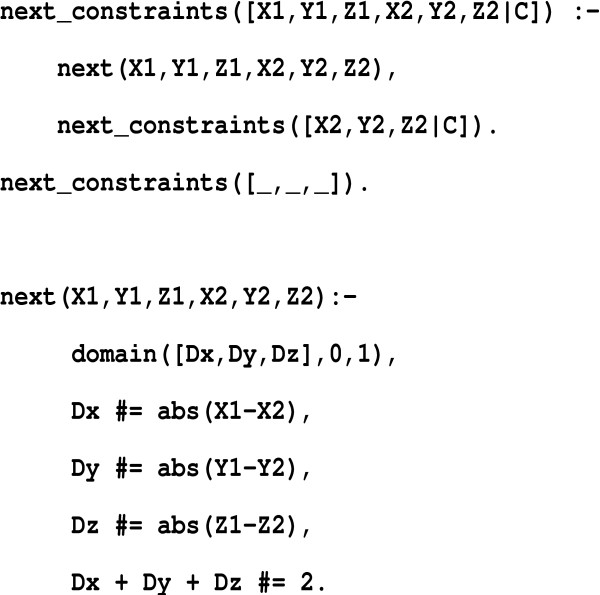
Code for stating that consecutive aminoacids must be in adjacent lattice points.